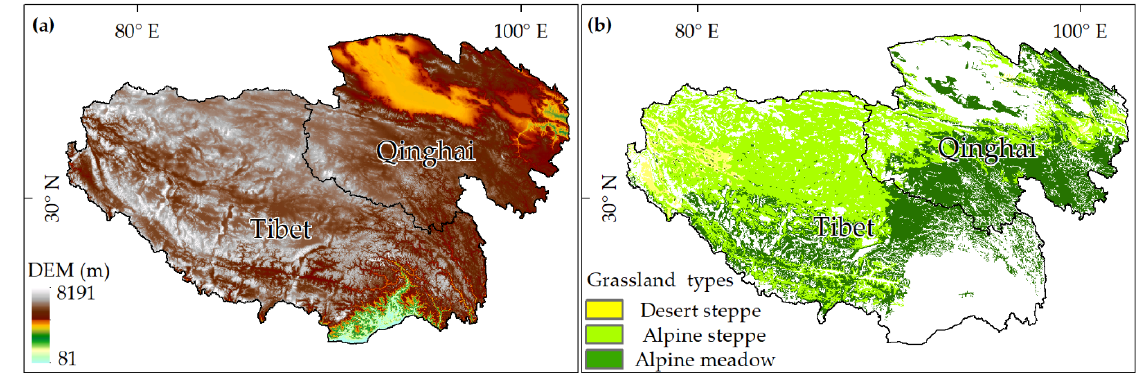
Figure 1. ( a ) The altitude of the study region and ( b ) the spatial pattern of the grassland types . DEM indicates digital elevation model.